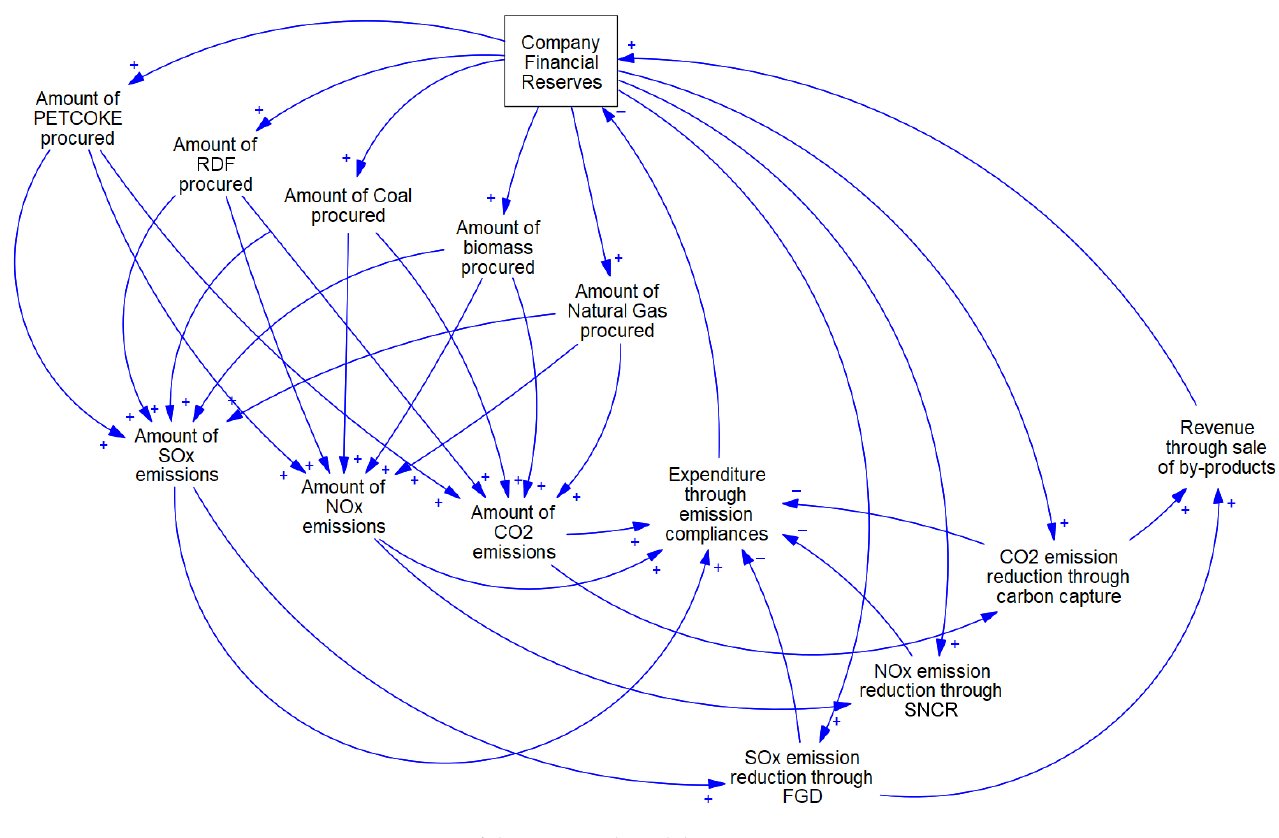
Figure 1. CLD of the proposed model.